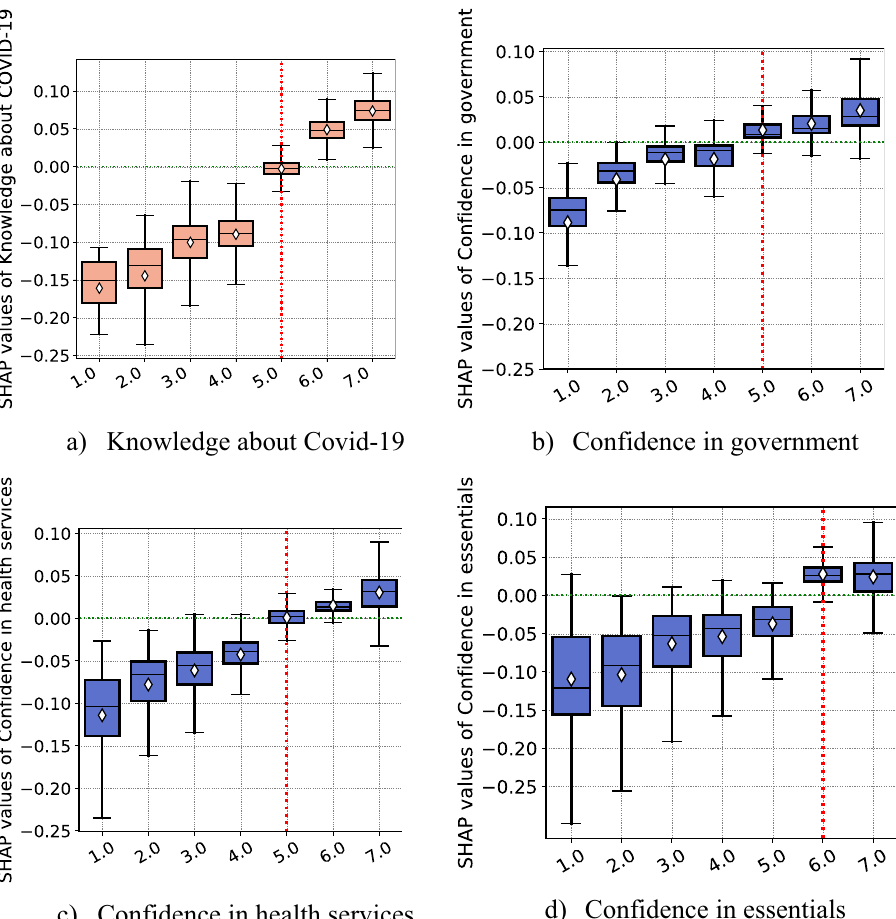
Figure 3. Partial effect of confidence in institutions and level of knowledge about COVID-19. Notes : Each panel ( a )–( d ) displays SHAP dependence boxplots of features related to trust in institutions and knowledge about COVID-19. The diamond symbol in the boxes denotes the average of SHAP value distribution per each